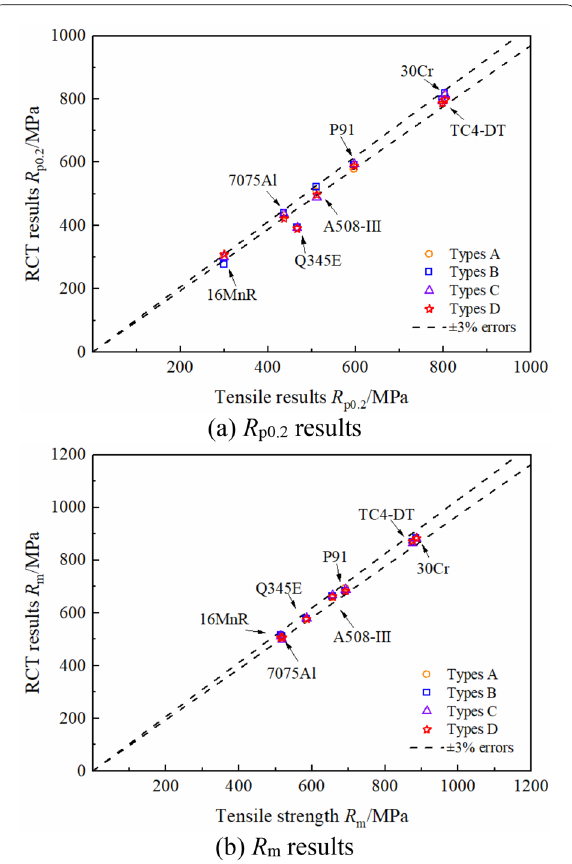
Figure 14 Comparison between the predicted yield and tensile strengths and those obtained by traditional tensile